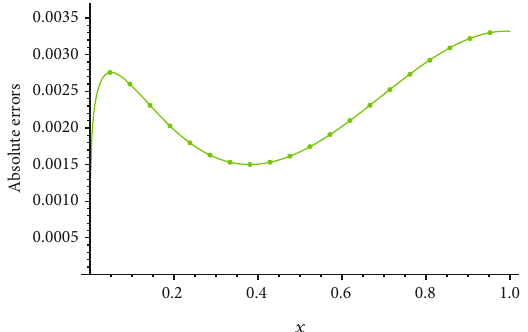
Figure 26: The numerical solution of u method with μ = 0 : 75,0 : 5,0 : 25,1 and exact solutions for Example 3.